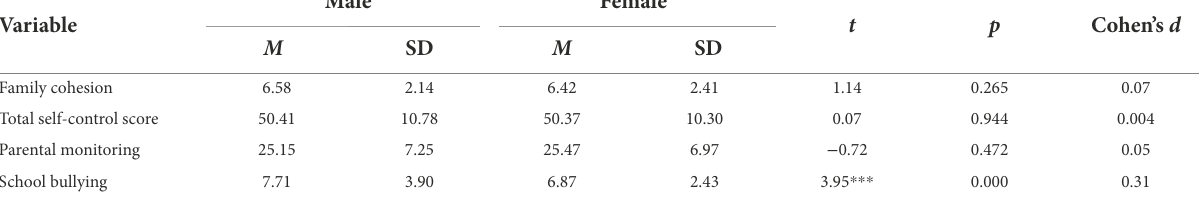
TABLE 1 Analysis of differences in variables on gender ( N = 1,026).